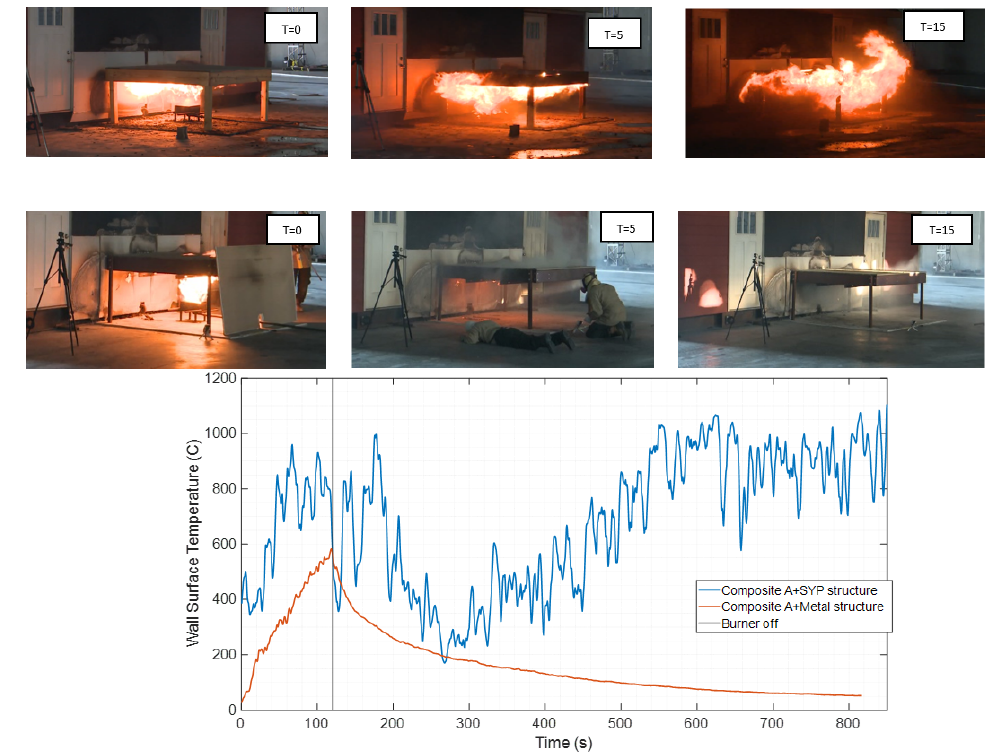
Figure 18. Time ‐ lapse of Composite A deck boards with ( First Row ) Southern Yellow Pine joists and ( Second Row ) metal supporting system, and the wall temperature.